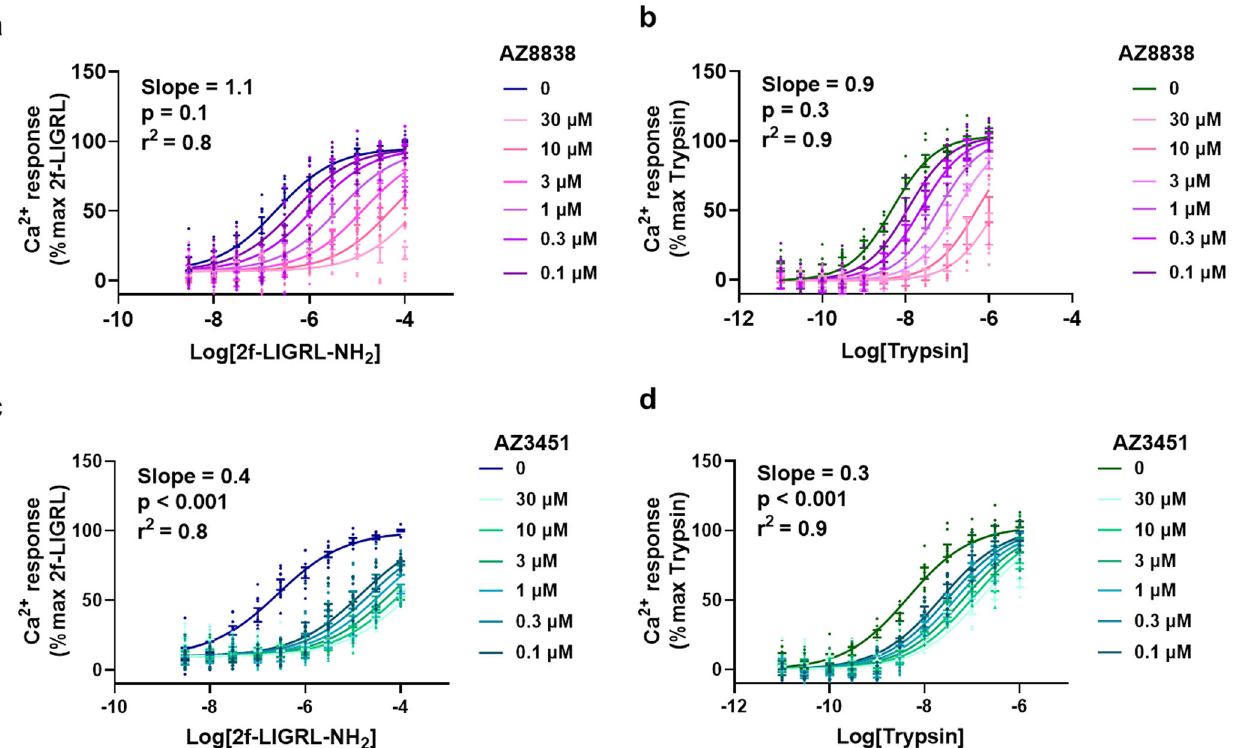
Fig. 4 Mechanistic understanding of PAR2 antagonists. Concentration – response curves for PAR2 agonists, 2f-LIGRL-NH 2 or trypsin, were measured in the presence of increasing concentrations of the two antagonists AZ8838 and AZ3451 in CHO-hPAR2 cells. AZ8838 was a competitive antagonist against a 2f-LIGRL-NH 2 ( n = 4) and b trypsin ( n = 3). In contrast, AZ3451 was a non-competitive antagonist against c 2f-LIGRL-NH 2 ( n = 3) and d trypsin ( n = 3). Data were analysed using Gaddum/Schild EC 50 global fi tting competitive model and the calculated Schild slopes are shown. By comparing the calculated Schild slope of AZ8838 and AZ3451 versus a hypothetical Schild slope = 1 using extra-sum of squares F- test, the p -values for AZ8838 against 2f-LIGRL- NH 2 and trypsin are >0.05 indicating that the calculated Schild slope for AZ8838 is not statistically distinguishable from a hypothetical Schild slope = 1. While the p -values for AZ3451 against 2f-LIGRL-NH 2 and trypsin are <0.001 indicating that the calculated Schild slope for AZ3451 is statistically distinguishable from a hypothetical Schild slope = 1. Data are presented as individual data points with error bar denoting s.e.m. of n > 3 independent